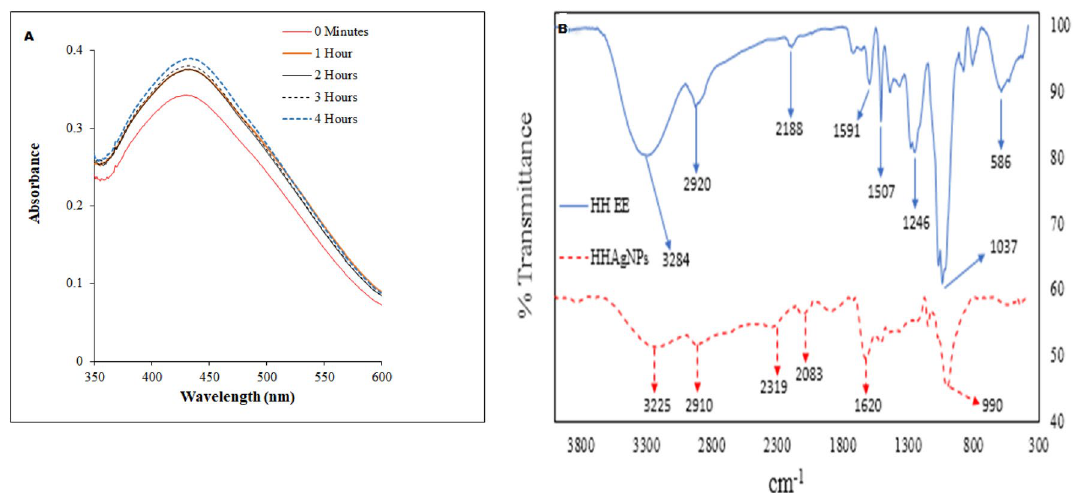
Figure 2. Nanoparticle formation: ( A ) UV spectrum of the AgNPs formed, ( B ) surface charge: FTIR spectra of the extract and